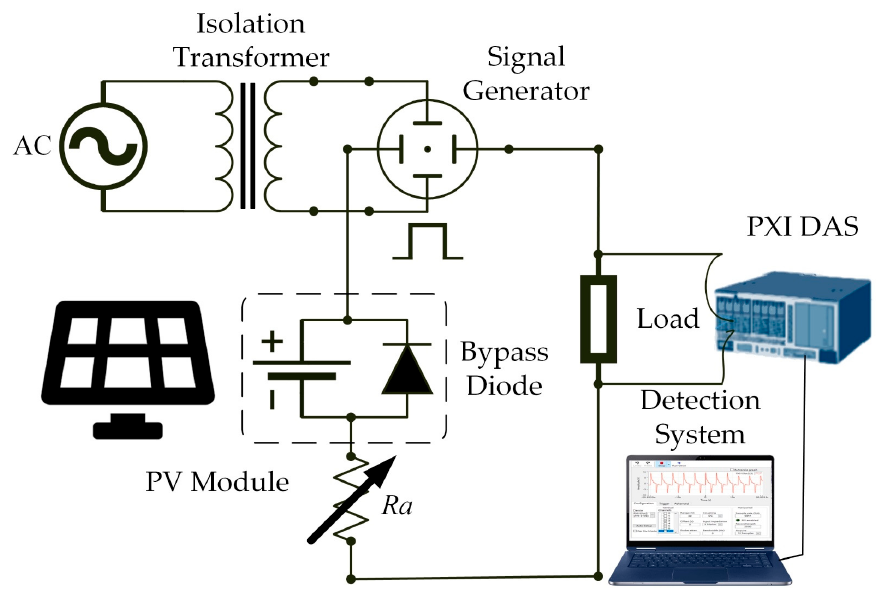
Figure 3. The circuit diagram of the PV module fault detection testing platform.